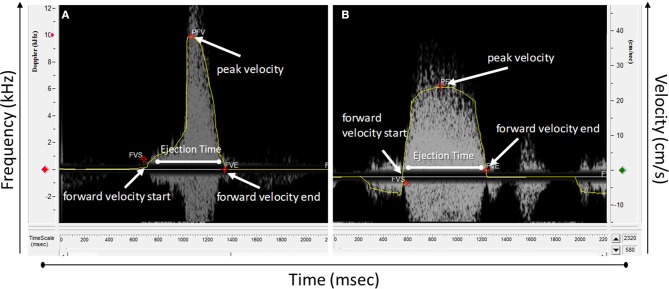
Doppler spectrograph waveform analyzed using Doppler workstation software. (A) A wave from an atrioventricular valve and (B) outflow track valve.